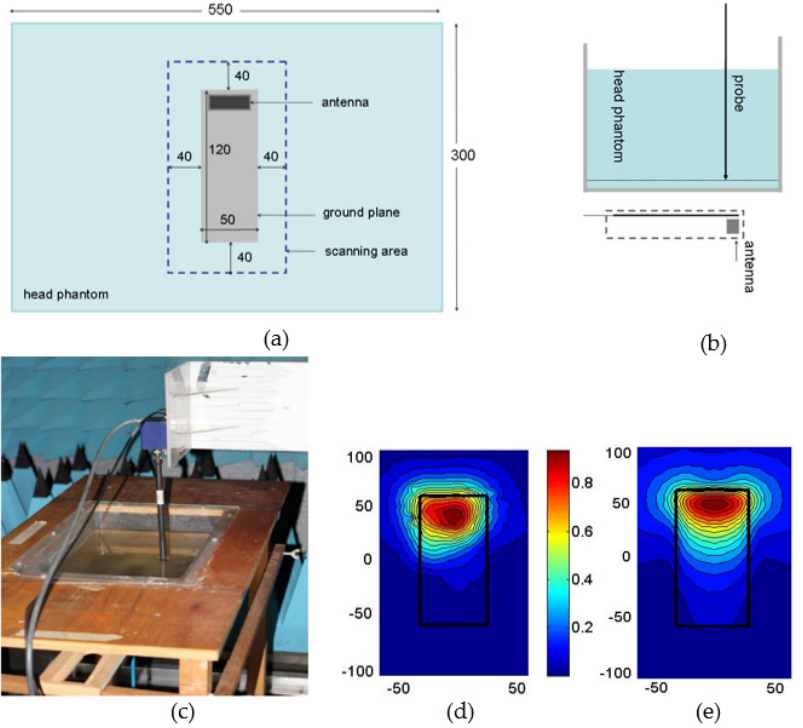
Figure 9. Experimental setup and SAR measurement, ( a ) bottom view; ( b ) side view; ( c ) practical photo; ( d ) measured normalised SAR; and ( e ) computed normalised SAR at 1.8 GHz.